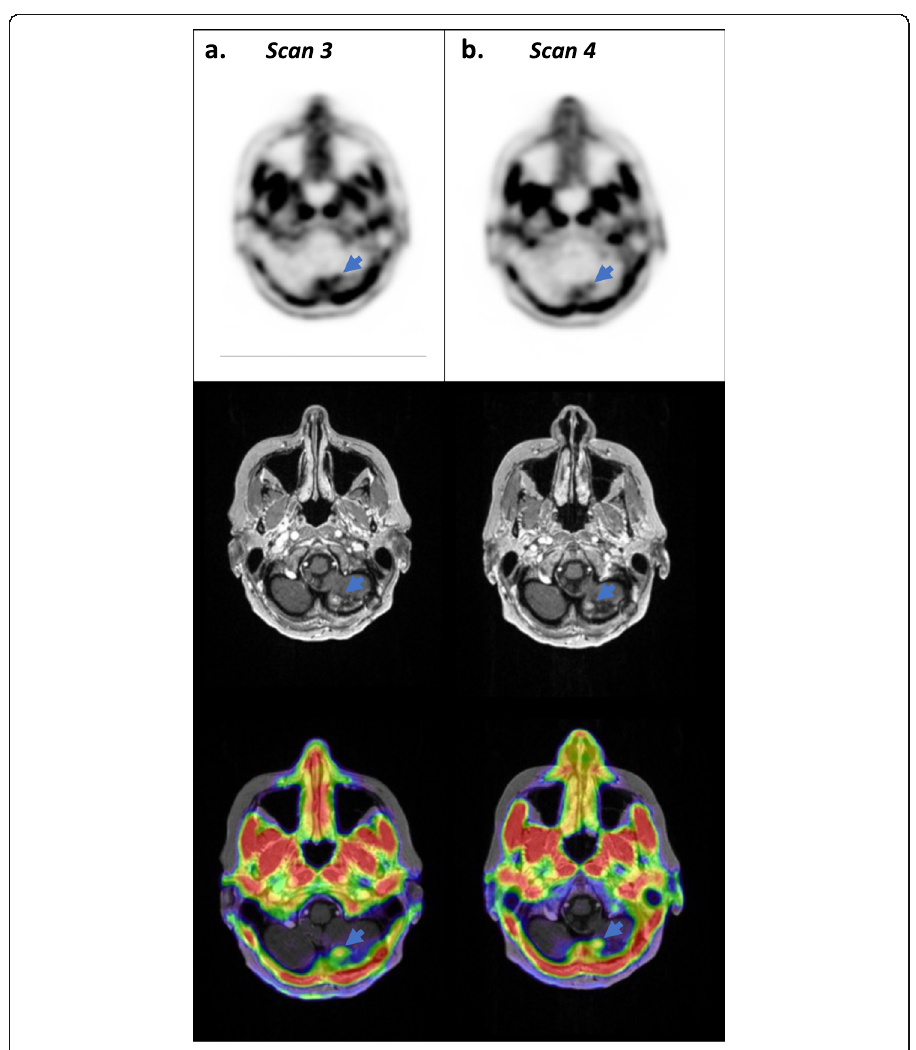
Fig. 2 Static PET, T1 MRI CE and fused PET/MR images of the cerebellar tumour in scans 3 and 4. Axial view of the patient ’ s left hemisphere caudomedial cerebellar metastasis (arrow) acquired using hybrid PET/MR imaging at time points 3 and 4. Static PET (20 – 35 min), T1 MRI CE and fused PET/MR images are shown from the top to bottom rows, respectively. Columns a and b show scans 3 and 4. The SUV scale for static cerebellar PET images was 0 – 2, and the SUV scale of fused PET/MR images was 0.45 –